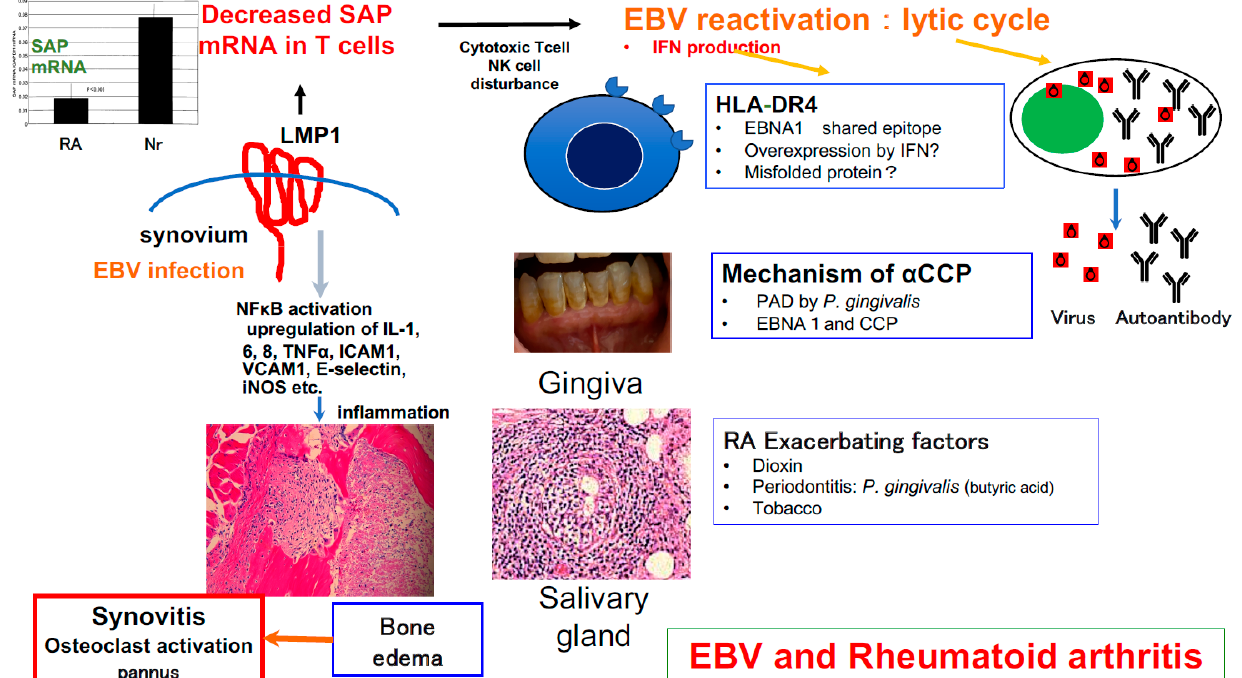
Figure 1. Inferring the role of EBV in RA synovitis. EBV is present in RA synovium, and LMP-1 expressed in synovial lining cells may suppress SAP function [56,104] and breaks down the normal defense mechanism against infection with EBV [85,103]. EBV activation might contribute to synovial cell proliferation, inflammation, and autoantibody production [52], and may be involved in the induction of RA synovitis. Additionally, environmental factors may contribute to EBV reactivation as follows: (1) Porphyromonas gingivalis peptidylarginine deiminase (PAD), an enzyme required for citrullination, engenders antigens leading to production of citrullinated peptides both in the gingiva and synovium [105]. (2) This bacterium also produces butyric acid, which induces EBV reactivation [106]. (3) Enhanced lytic replication of EBV induced by dioxin and tobacco is also a risk factor for the development of autoimmune diseases [107,108]. EBV infection in humanized NOG mice resulted in a pathological condition characterized by erosive arthritis that is also seen in human rheumatoid arthritis; EBV infection is thus thought to be directly involved in RA pathogenesis [92].